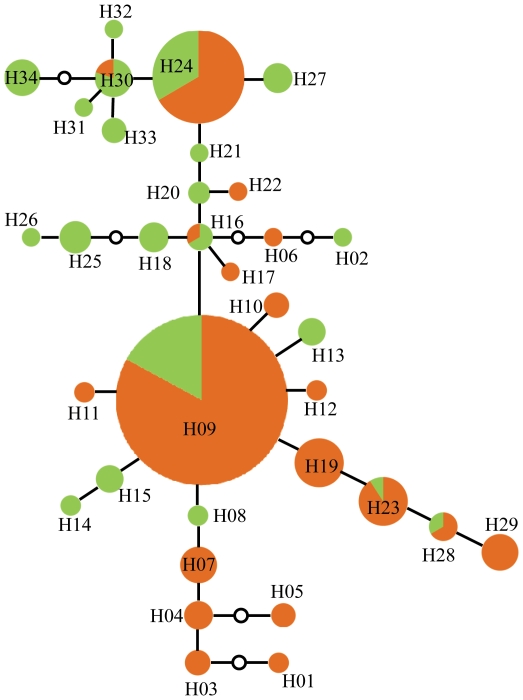
The genealogical network for C. guadalupensis (green) and C. forbesii (orange).